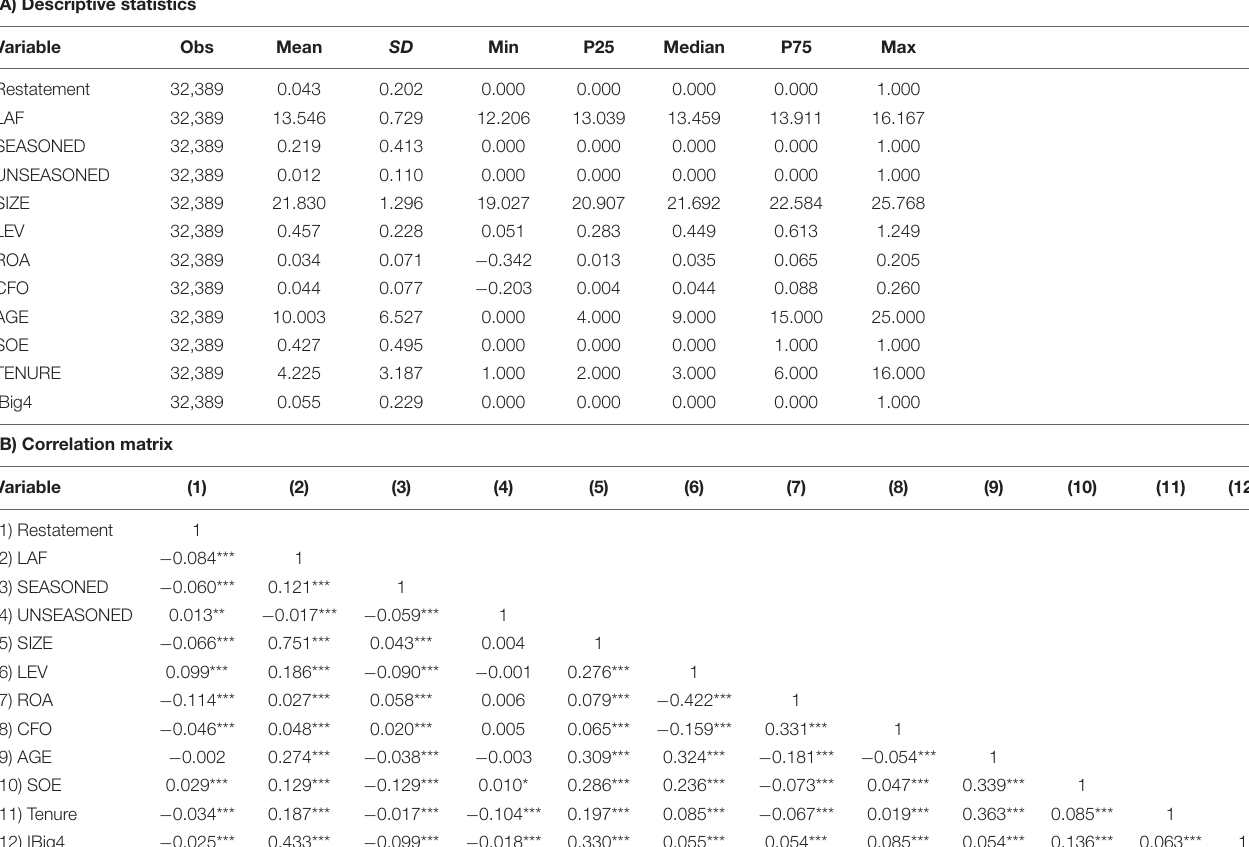
TABLE 2 | Descriptive statistics and correlation